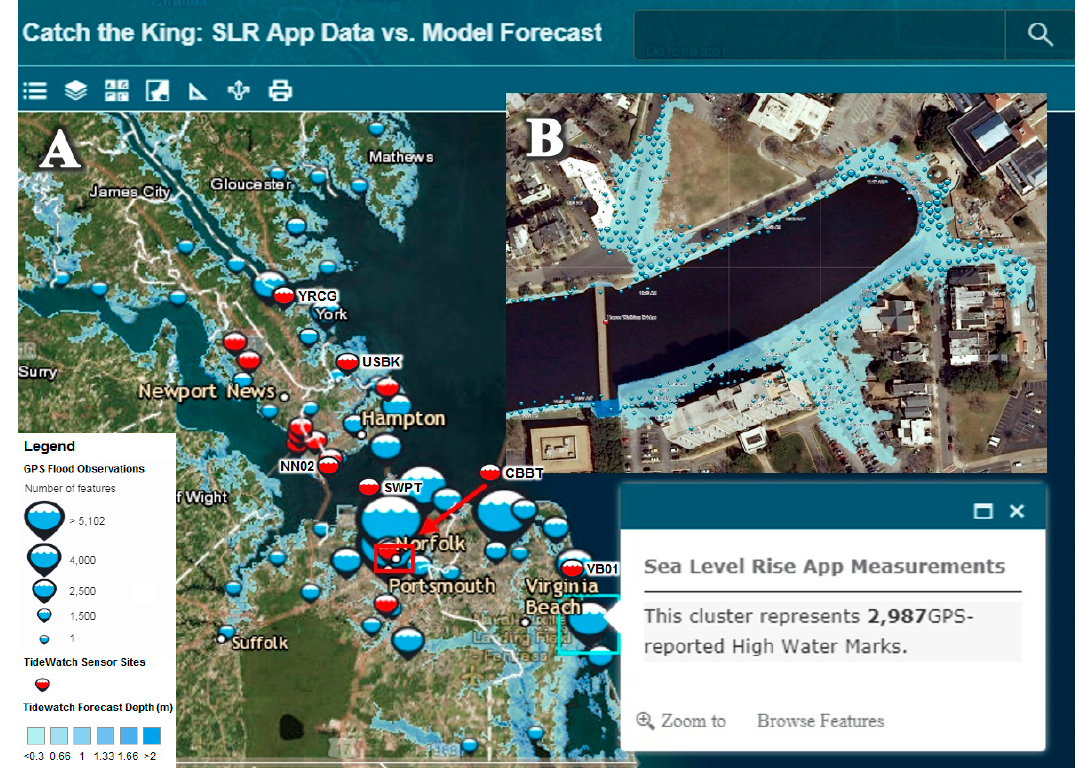
Figure 6. ( A ) Overview of study region in Hampton Roads, VA, featuring the 2017 king tide maximum inundation forecast from the Tidewatch Map in blue, GPS citizen science observations as blue dots, and water level sensors from the Tidewatch Charts as red dots. ( B ) Inset shows a high-density concentration of flood validation data in the historic Hague region of Norfolk, VA, USA, where the model had favorable agreement with the citizen science observations. Here, the model yielded a 94% spatial match, and a 4.2 m MHDD. See the map online: http://arcg.is/1HLOPS.